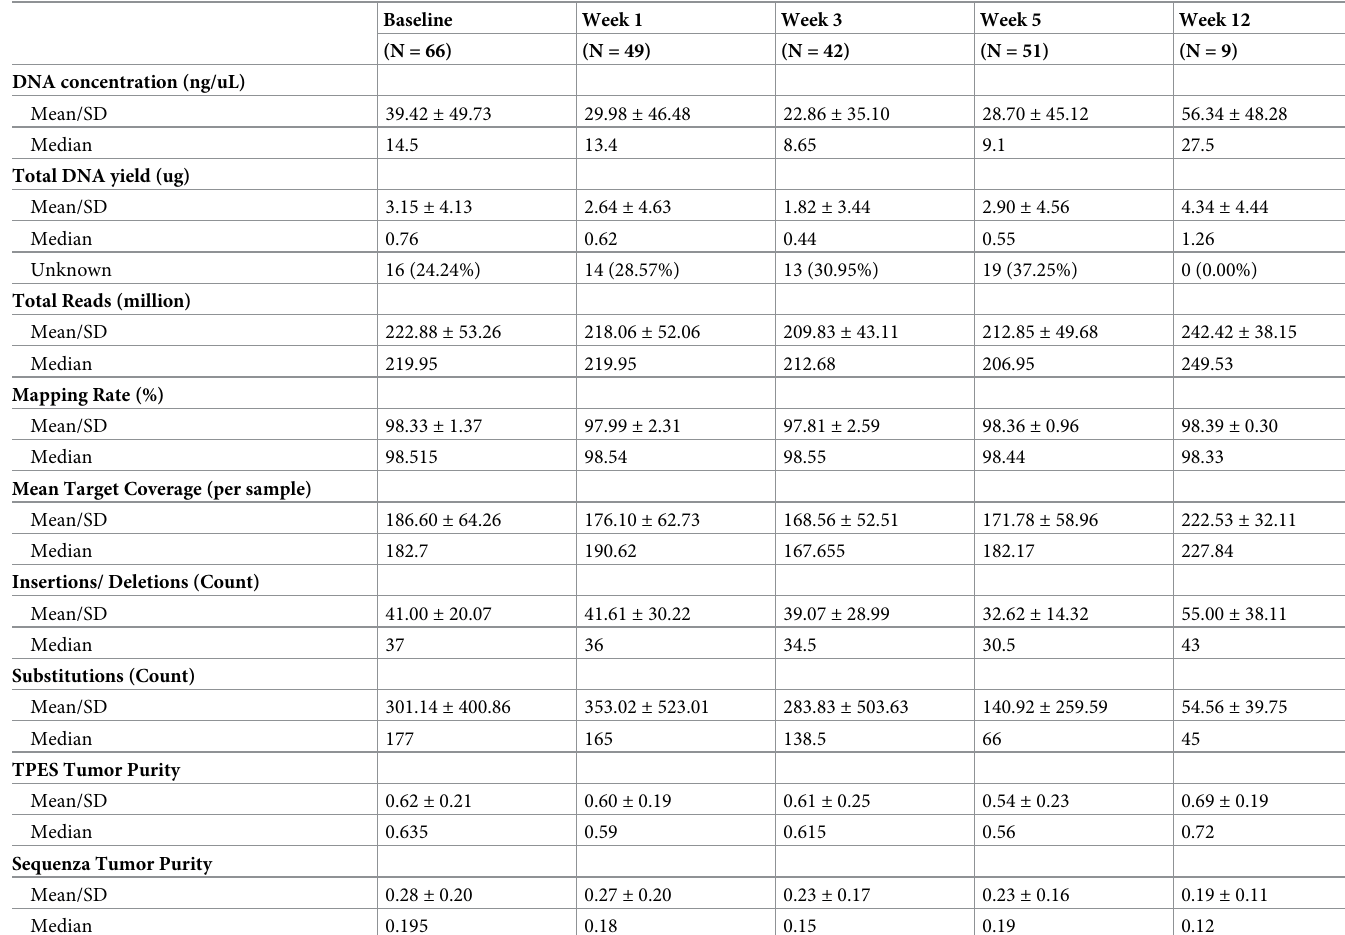
Table 2. Quality characteristics for samples by